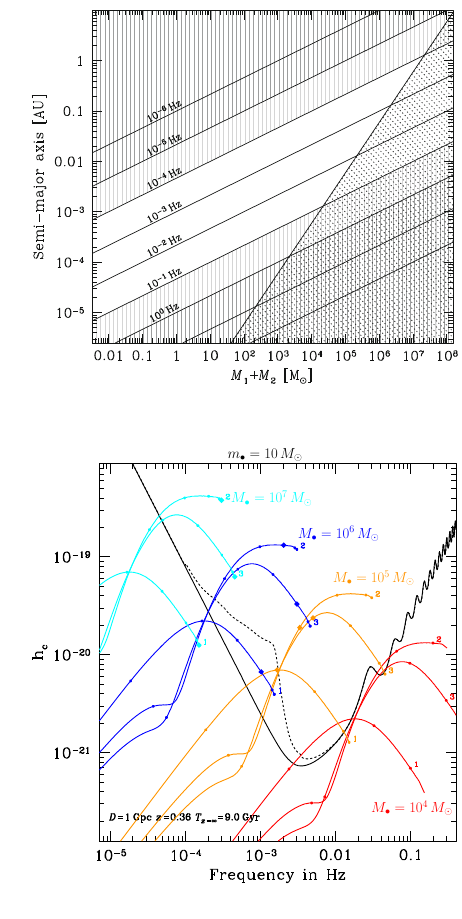
Fig. 39 Frequency of a binary of total mass M 1 + M 2 against their semi-major axis and the corresponding frequencies. The solid, dark straight line delimits the LSO, so that anything on the right of that line is of no interest for our purposes